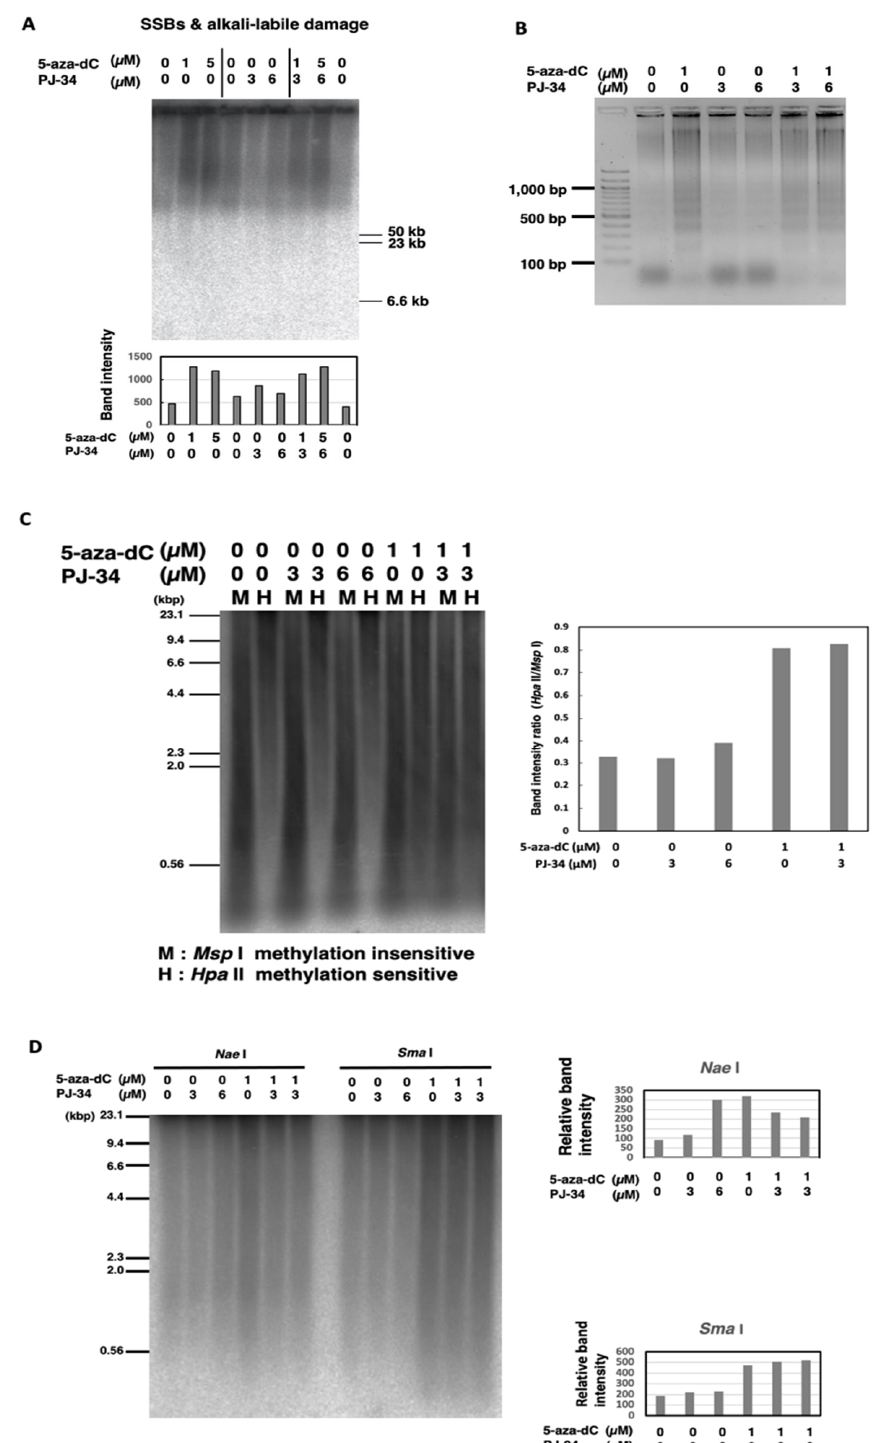
Figure 3. Effect of PJ-34 and 5-aza-dC on SSBs and alkali-labile DNA damage and apoptotic DNA fragmentation and DNA methylation in colon cancer HCT116 cells. ( A ) The cells were treated with 5-aza-dC, PARP inhibitors PJ-34 for 3 days and genome DNA was analyzed by pulse-field gel electrophoresis in alkaline treatment to observe SSBs and alkali-labile DNA damage and detected with total genome probe by Southern blot analysis. The band intensity was quantified and plotted in the graph shown below. ( B ) Induction of apoptotic DNA ladder formation on day 6 with 5-aza-dC treatment but not with PARP inhibitor. No enhancement of DNA ladder formation was observed